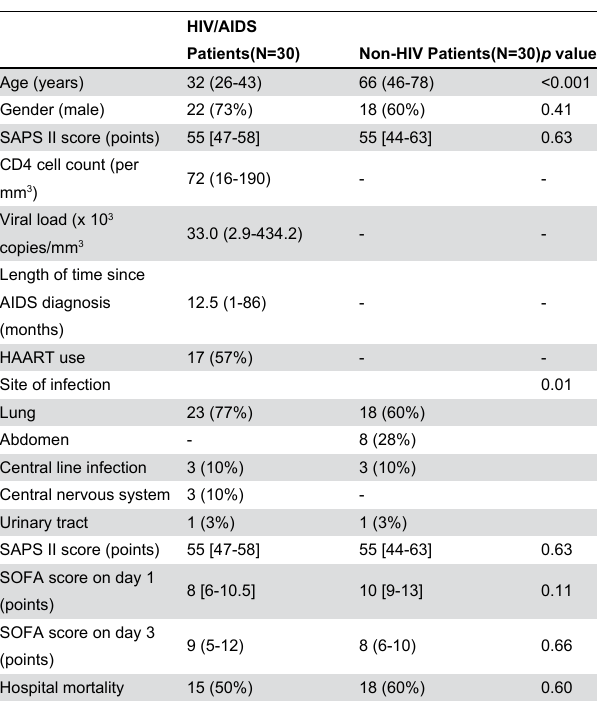
Table 1. Characteristics of HIV/AIDS and non-HIV septic patients. The results were expressed as the median and the interquartile